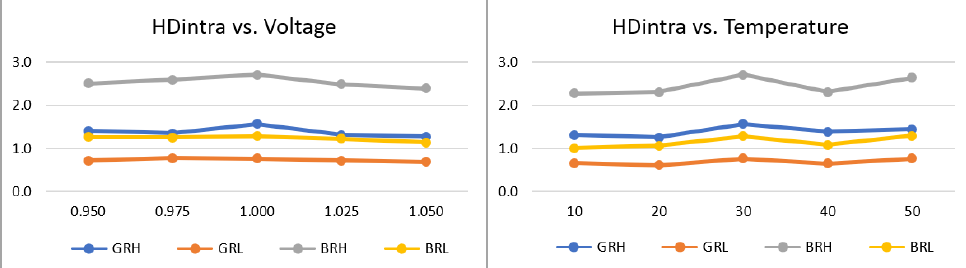
Figure 17. HDintra mean versus voltage ( left ) and temperature ( right ) variations for the test systems implemented in the Nexys A7 board.